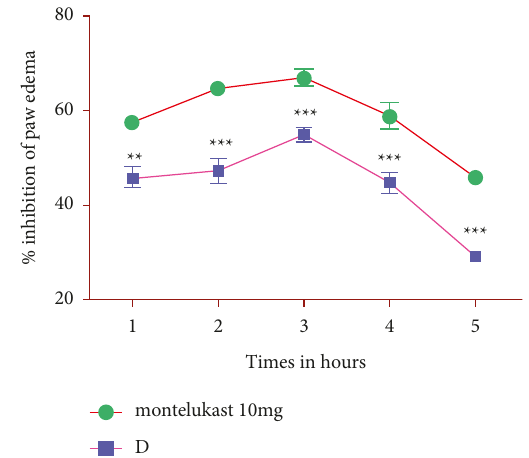
Figure 6: Percent inhibition produced by montelukast (10mg/kg) and compound D (100mg/kg) in the leukotriene-induced paw edema model in mice. Each percent point represents the mean- SEM for a group of 8 mice. Data were analyzed by ANOVA followed by post hoc Dunnett’s test. Asterisks show significant values. ± value.